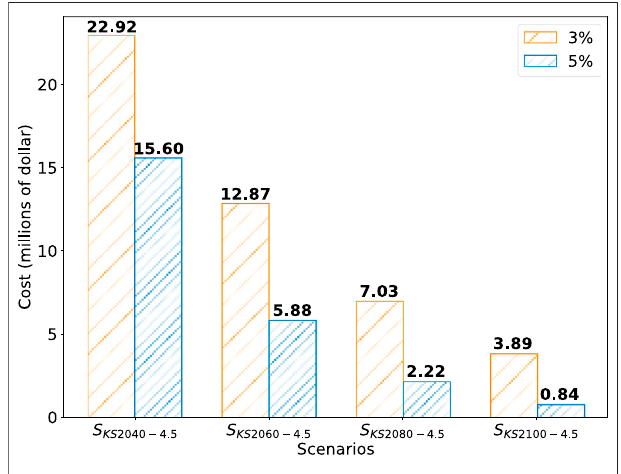
FIGURE 18 | Hurricane damage cost when no retro fi t is done (A) .